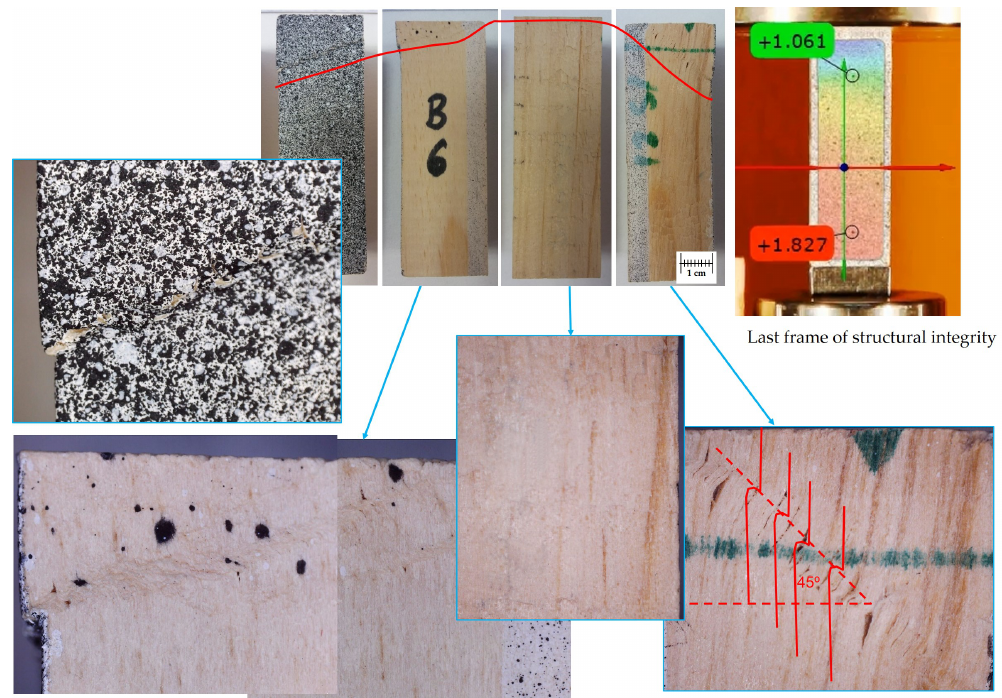
21 Figure 21. Appearance of the damage produced in the specimen B6. Comparison with the last frame of